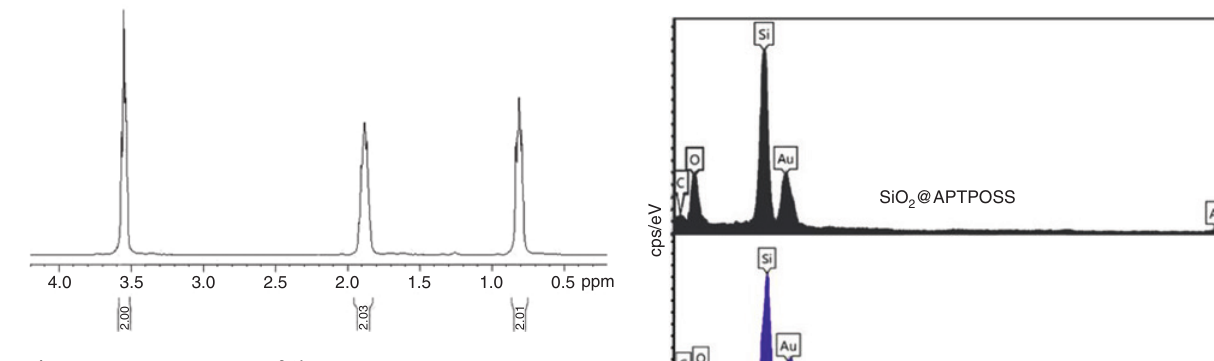
Figure 1: 1 H NMR spectrum of Cl-POSS.